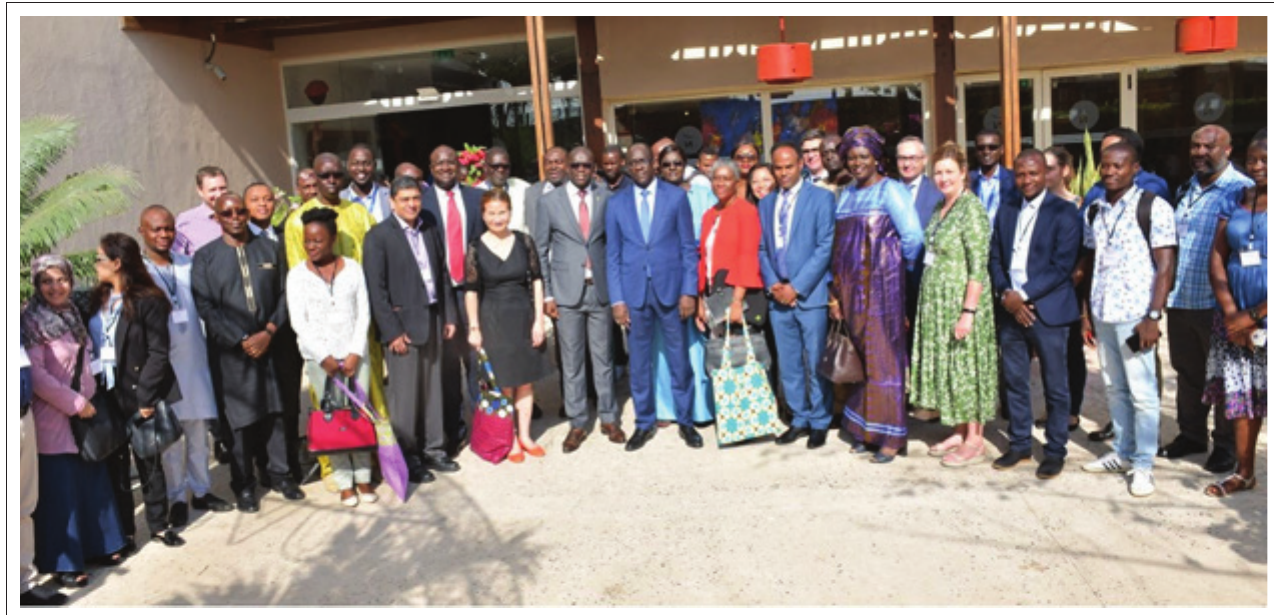
FIGURE 2: First training on laboratory diagnosis of COVID-19 in Dakar, Senegal, 06–08 February